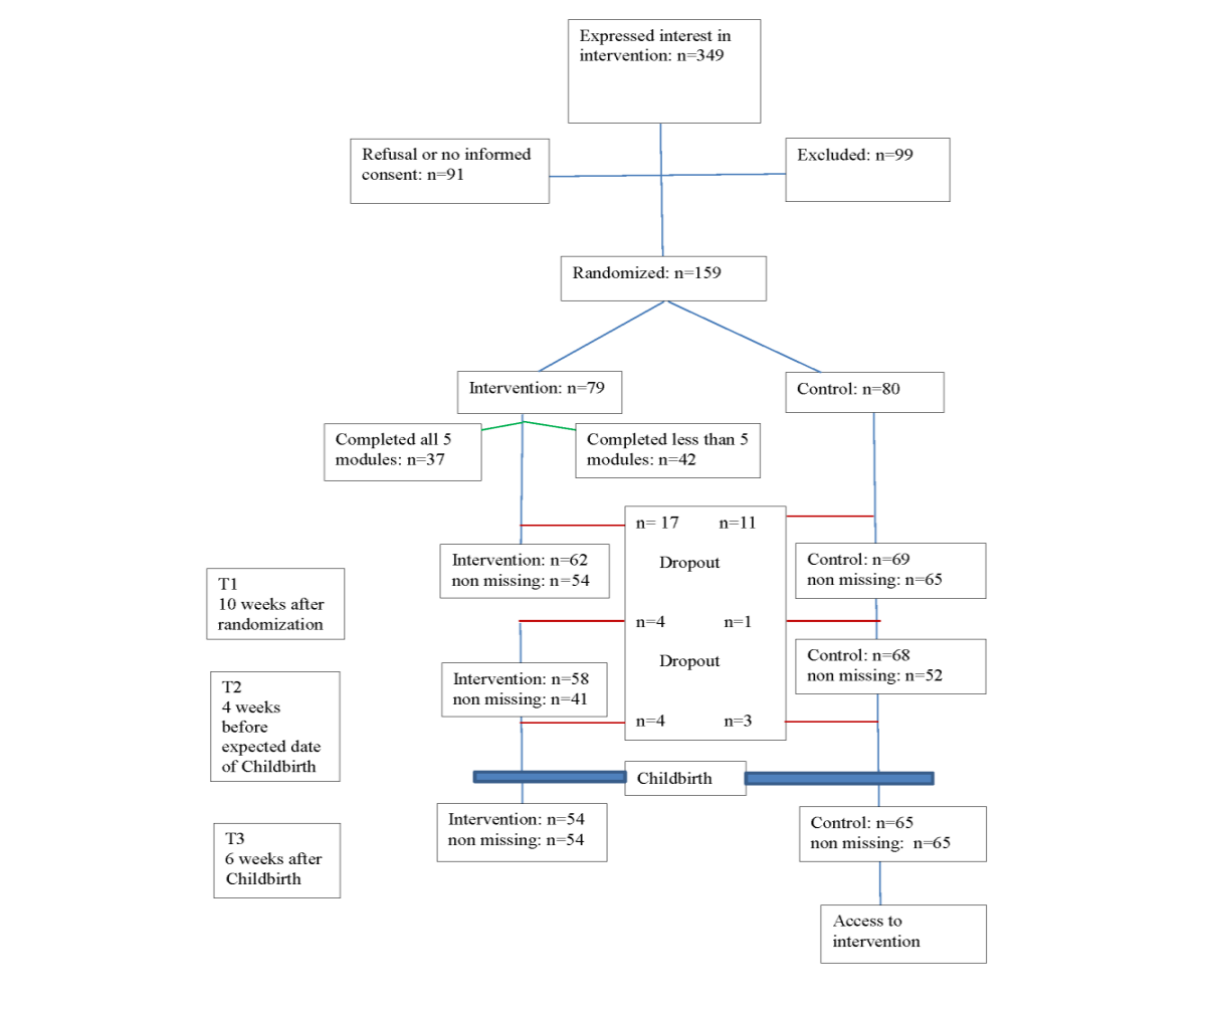
Figure 1. Flowchart of participants throughout the trial. Intervention: still in intervention group, but not everyone participated in this assessment; Control: still in control group, but not everyone participated in this assessment; Nonmissing: did participate in this assessment; Dropout: not in study